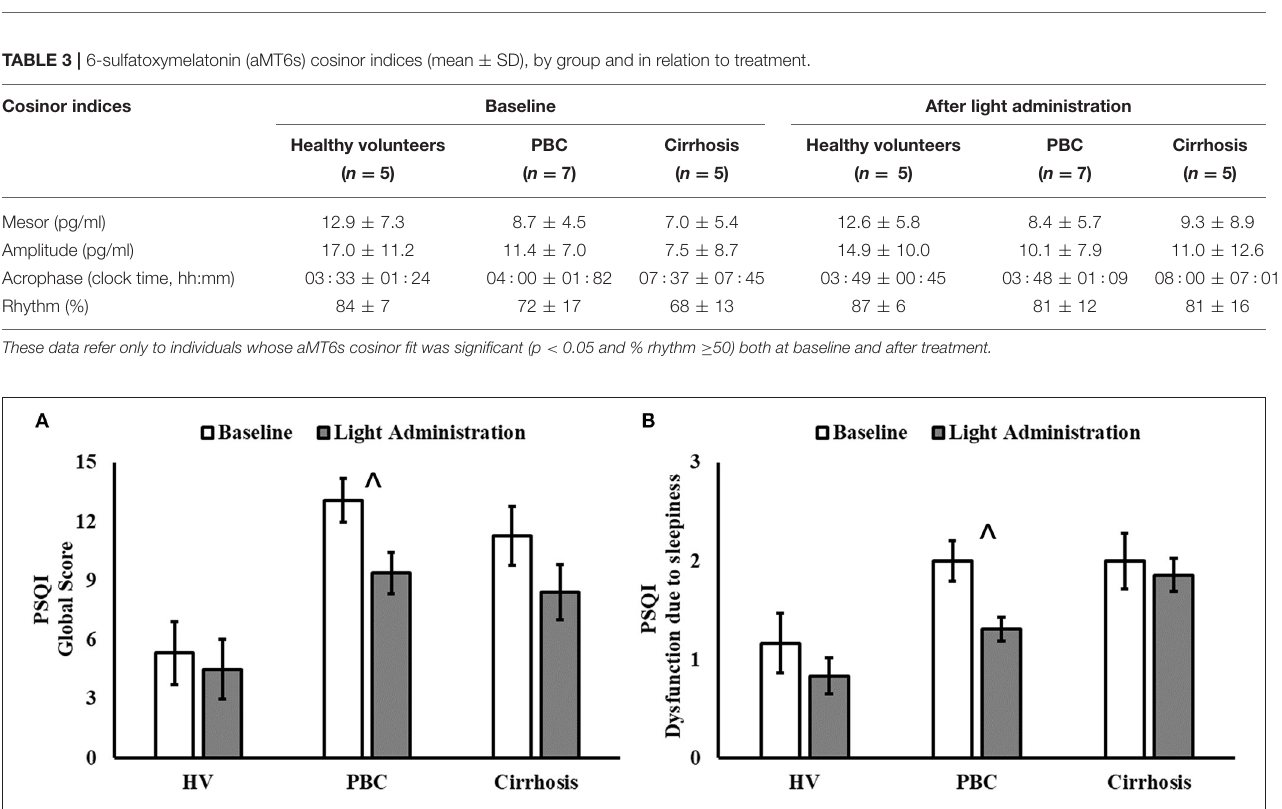
FIGURE 1 | Pittsburgh Sleep Quality Index (PSQI) Global Score (A) and Component 7 (Dysfunction due to sleepiness; (B) before (white columns) and after 2 weeks of light administration (gray columns), by patient category (HV, healthy volunteers; PBC, Primary Biliary Cholangitis). (A) Patient category: p = 0.007; treatment: p < 0.001; patient category × treatment: p = 0.120; ∧ post-hoc significant for PBC: p < 0.001. (B) Patient category: p = 0.010; treatment: p = 0.011; patient category × treatment: p = 0.280; ∧ post-hoc significant for PBC: p = 0.021.